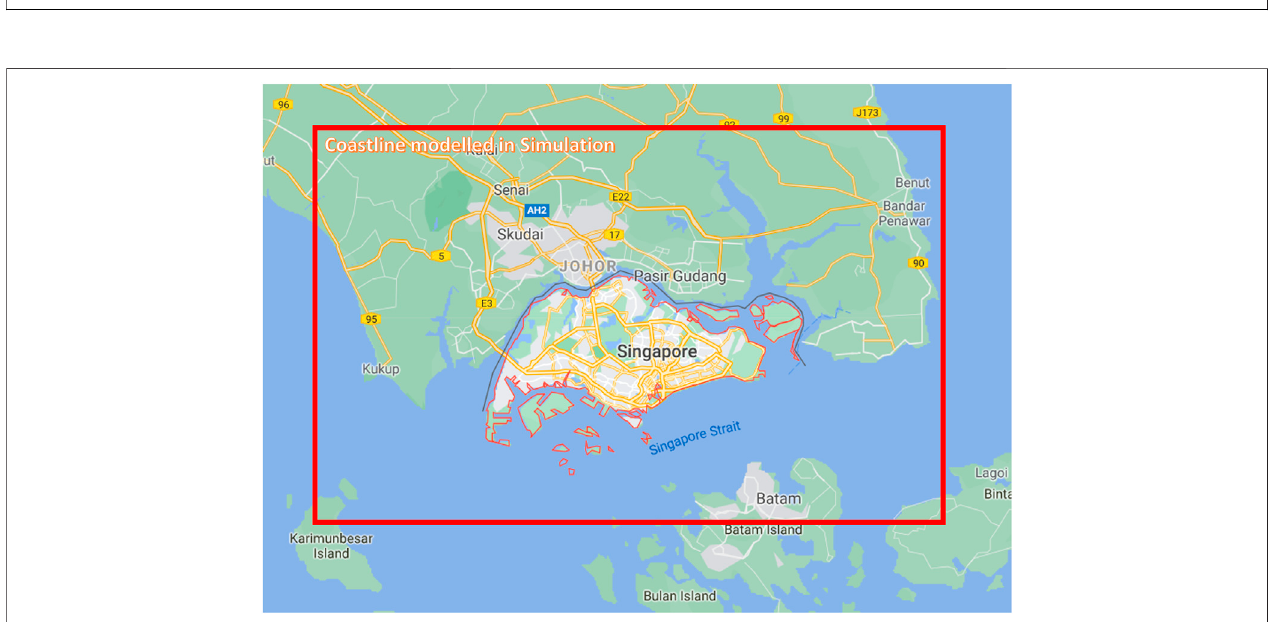
FIGURE 2 | Singapore Location map (Source